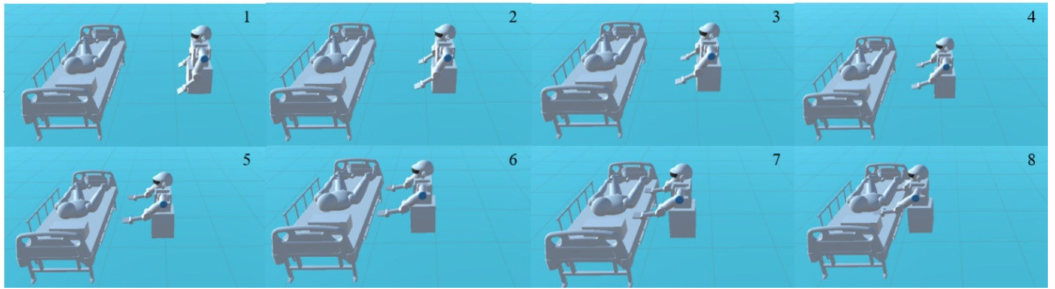
Figure 13. Diagram of training results. The number in the upper right corner of the picture represents the moving order of the